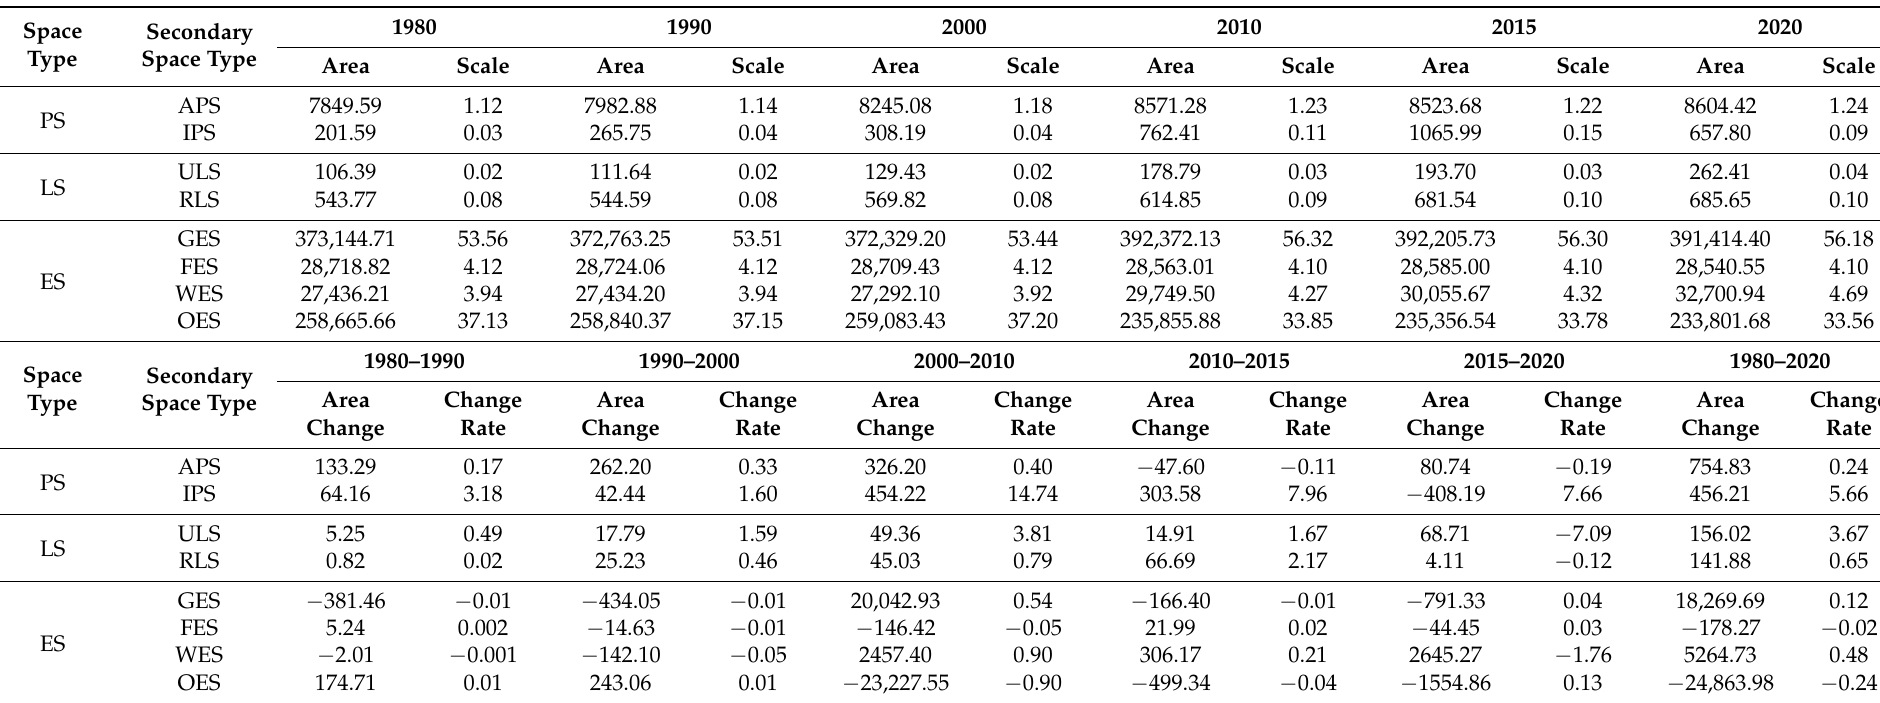
Table 4. Structural changes of production-living-ecological space types in Qinghai Province from 1980–2020 (km 2